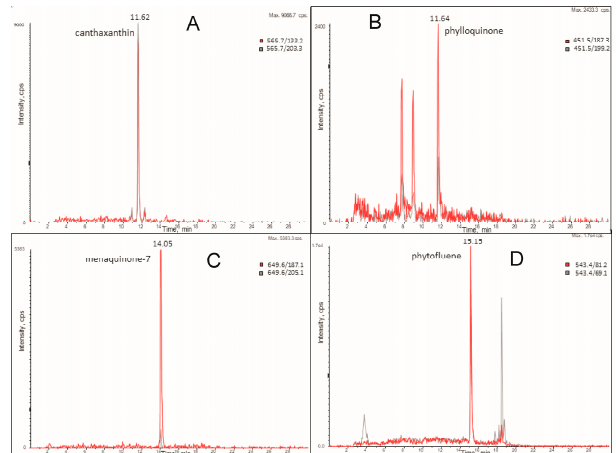
Figure 5. LC-MRM profile of retinol ( A ), gamma-tocopherol ( B ), alpha tocopherol ( C ) and lutein ( D ) extracted from a microalga sample by SFE. Extraction conditions: P CO2 = 35 MPa, T CO2 = 40 °C, 5% MeOH.